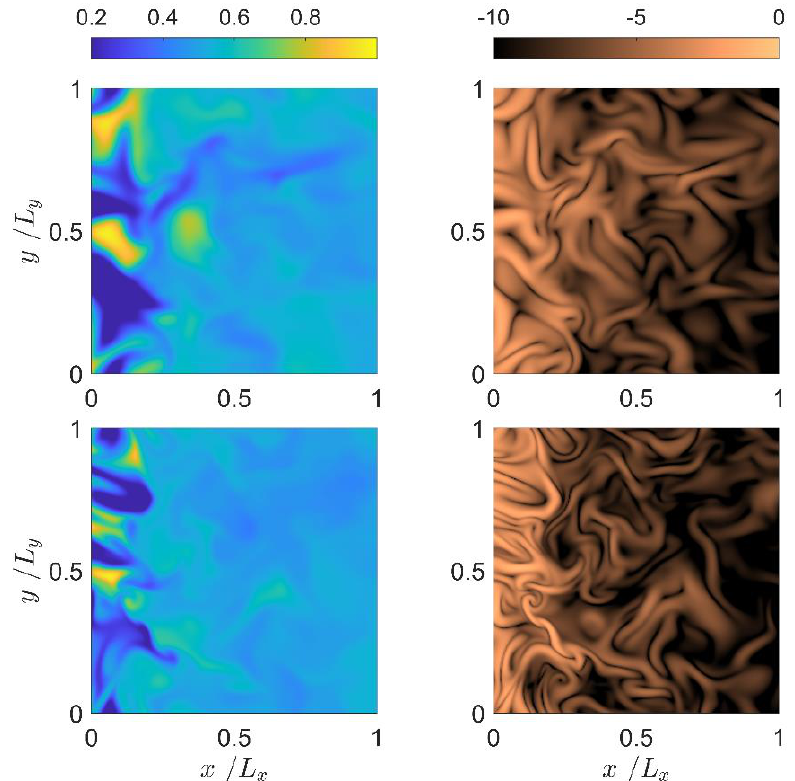
Figure 4. Spatial distributions of 𝑐 based on CH 4 mass fraction (1 st column) and the natural logarithm of its normalised SDR ln ( 𝑁 𝑐 × 𝑙 0 /𝑢 0′ ) (2 nd column) in the central midplane for passive scalar mixing for initial 𝑢 ′ /𝑆 𝐿 = 4.0 (1 st row) and 8.0 (2 nd row).